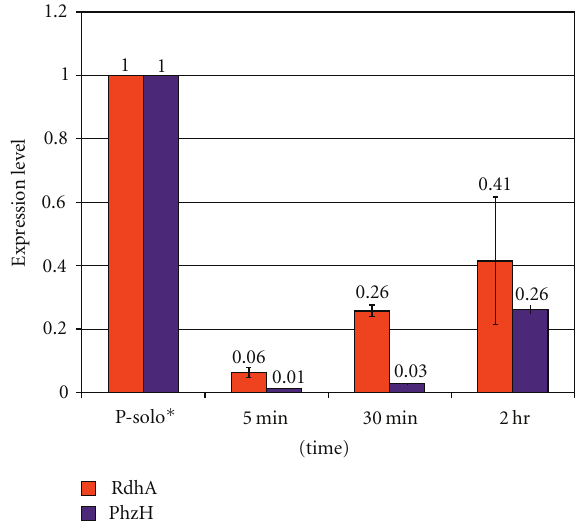
Figure 1: P. aeruginosa gene expression in the P. aeruginosa-R. denitrificans R. denitrificans co-cultures. Relative gene expression levels of P. aeruginosa RdhA and PhzH genes in dual co-cultures of P. aeruginosa-R. denitrificans were determined by quantitative real- time PCR (qPCR) with the SYBR green method [15].